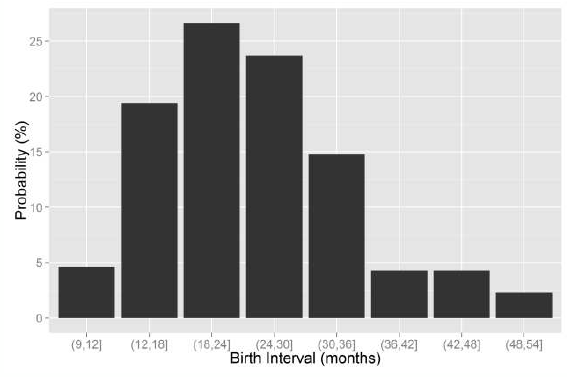
Figure A1.4: Time between births, plotted from survey data from the